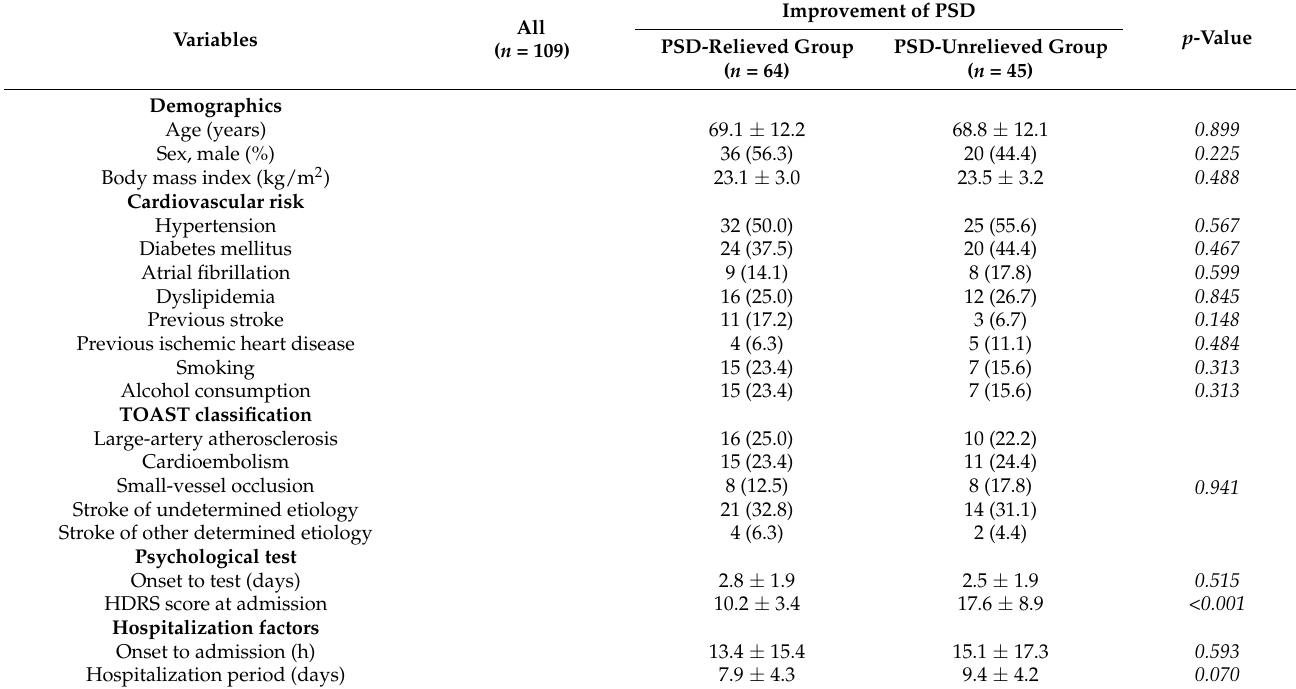
Table 3. Baseline Characteristics of PSD-Relieved and -Unrelieved Patients After Three